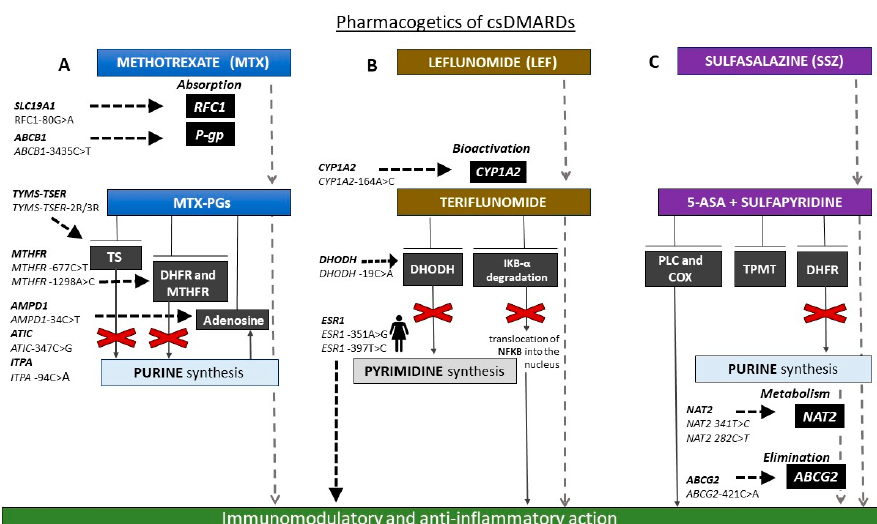
Figure 1. Schematic representation of the main pharmacogenetic biomarkers associated with conventional synthetic disease ‐ modifying antirheumatic drug (csDMARD) treatment. ( A ) Methetrexate (MTX) is absorbed by reduced folate carrier 1 (RFC1) transporter, encoded by human solute carrier family 19 member 1 (SLC19A1). Patients with RFC1 ‐ 80AA genotype responded better to MTX than ‐ 80AG and ‐ 80GG individuals. ATP ‐ binding cassette subfamily B member 1 (ABCB1) ‐ 3435CT single nucleotide polymorphism (SNP) may influence the MTX absorption and therapy response. MTX is converted into MTX ‐ polyglutamates (MTX ‐ PGs), which in turn inhibit folate pathway enzymes thymidilate synthase (TS), dihydrofolate reductase (DHFR), and methylene tetrahydrofolate reductase (MTHFR) and increase adenosine release. Individuals carrying ‐ 3R allele of the genetic variant in the enhancer region of thymidylate synthase (TYMS; thymidylate synthase enhancer region (TSER)), encoding TS (TYMS ‐ TSER ‐ 2R/3R) have higher TYMS mRNA expression than those with ‐ 2R and require a higher MTX dosage. MTHFR ‐ 677CT and ‐ A1298AC SNPs lead to lower MTHFR enzyme activity. Moreover, MTX response and toxicity may be affected by SNPs in genes involved in adenosine signaling (adenosine monophosphate deaminase 1 (AMPD1) ‐ 34C>T, 5 ‐ aminoimidazole ‐ 4 ‐ carboxamide ribonucleotide formyltransferase/inosine monophosphate cyclohydrolase (ATIC) ‐ 347C>G, inosine triphosphate pyrophosphatase (ITPA) ‐ 94C>A). ( B ) Leflunomide (LEF) is converted into the active form, teriflunomide, mainly by CYP1A2. CC genotype of CYP1A2 ‐ 164AC SNP is associated with increased LEF toxicity. Teriflunomide inhibits dihydroorotate dehydrogenase (DHODH; enzyme involved in the biosynthesis of pyrimidines) and nuclear factor of kappa light polypeptide gene enhancer in B cells inhibitor alpha (I κ B α ) degradation. DHODH ‐ 19CC patients respond better than ‐ 19AA. The efficacy of LEF is superior in patients with ESR1 rs9340799 AA and ESR1 rs2234693 TT genotypes. ( C ) Polymorphisms in genes coding for N ‐ acetyltransferase 2 (NAT2) and ATP ‐ binding cassette subfamily G member 2 (ABCG2), involved, respectively, in drug metabolism and elimination, could influence response and safety of sulfasalazine. Patients carrying loss of function (LoF) allele A of the ABCG2 ‐ 421CA SNP respond better than carriers of LoF allele of NAT2 ‐ 341TC, and ‐ 282CT is associated with high ‐ risk toxicity. csDMARDs, conventional synthetic disease ‐ modifying antirheumatic drugs; MTX, methetrexate; SLC19A1, human solute carrier family 19 member 1; RFC1, reduced folate carrier 1; P ‐ gp, P ‐ glycoprotein; ABCB1, ATP ‐ binding cassette subfamily B member 1; MTX ‐ PGs, MTX ‐ polyglutamate: TYMS ‐ TSER, thymidylate synthase ‐ thymidylate synthase enhancer region; TS, thymidilate synthase; DHFR, dihydrofolate reductase; MTHFR, methylene tetrahydrofolate reductase; AMPD1, adenosine monophosphate deaminase 1; ATIC, 5 ‐ aminoimidazole ‐ 4 ‐ carboxamide ribonucleotide formyltransferase/inosine monophosphate cyclohydrolase; ITPA, inosine triphosphate pyrophosphatase; DHODH, dihydroorotate dehydrogenase; I κ B α , nuclear factor of kappa light polypeptide gene enhancer in B cells inhibitor, alpha; NF κ B, nuclear factor kappa ‐ light ‐ chain ‐ enhancer of activated B cells; ESR1, estrogen receptor 1; TPMT, thiopurine methyltransferase; 5 ‐ ASA, 5 ‐ aminosalicylic acid; TPMT, thiopurine S ‐ methyltransferase; NAT2, N ‐ acetyltransferase 2; ABCG2, ATP ‐ binding cassette subfamily G member 2.